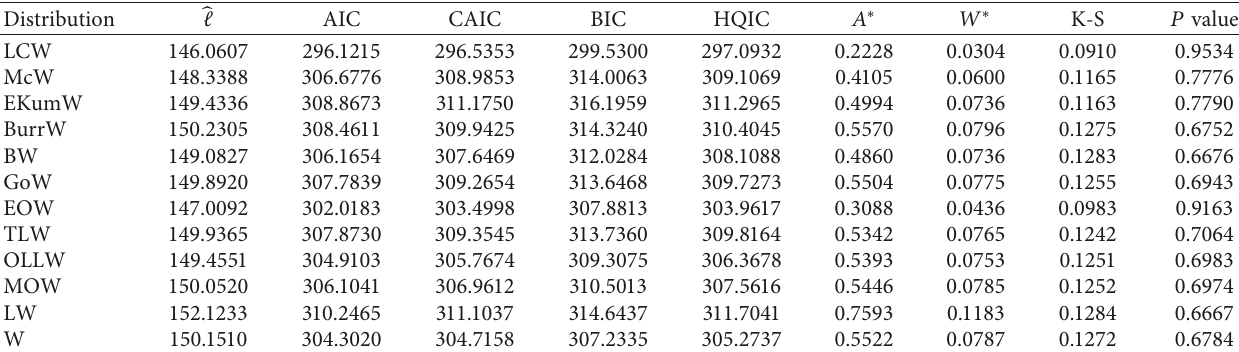
Table 8: 􏽢 ℓ , AIC, CAIC, BIC, HQIC, A ∗ , W ∗ , K-S, and P values for survival time